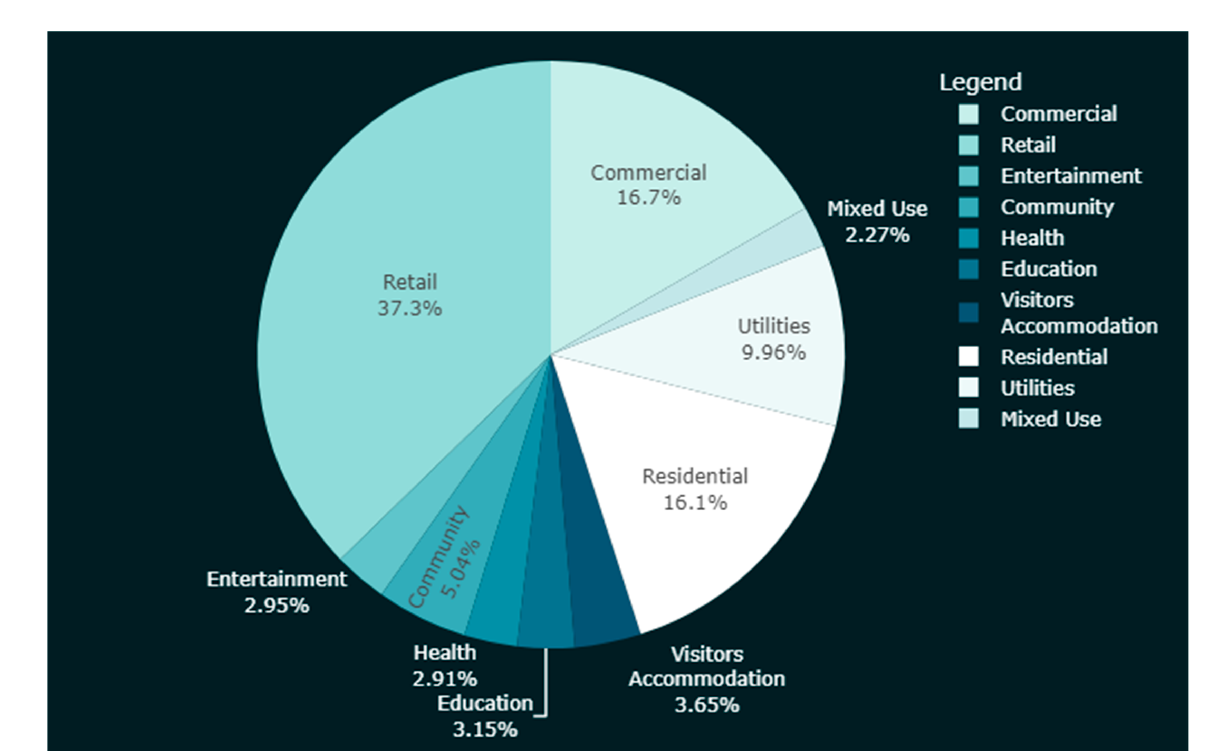
Figure 31. Use distribution of approved DAs where a proposed use can be identified (2004–2022).